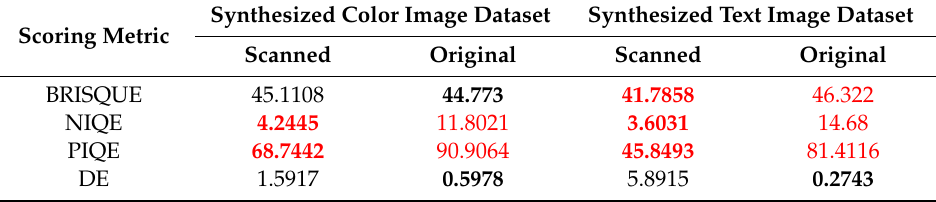
Table 1. Comparison of image quality measures using original unscanned reference images as ground truths (note: higher values denote lower quality). Scores are measured as the average across the full dataset of approximately fifty images in each case. Highlighted in red is where the measure erroneously gives a worse value to the better image (the original unscanned